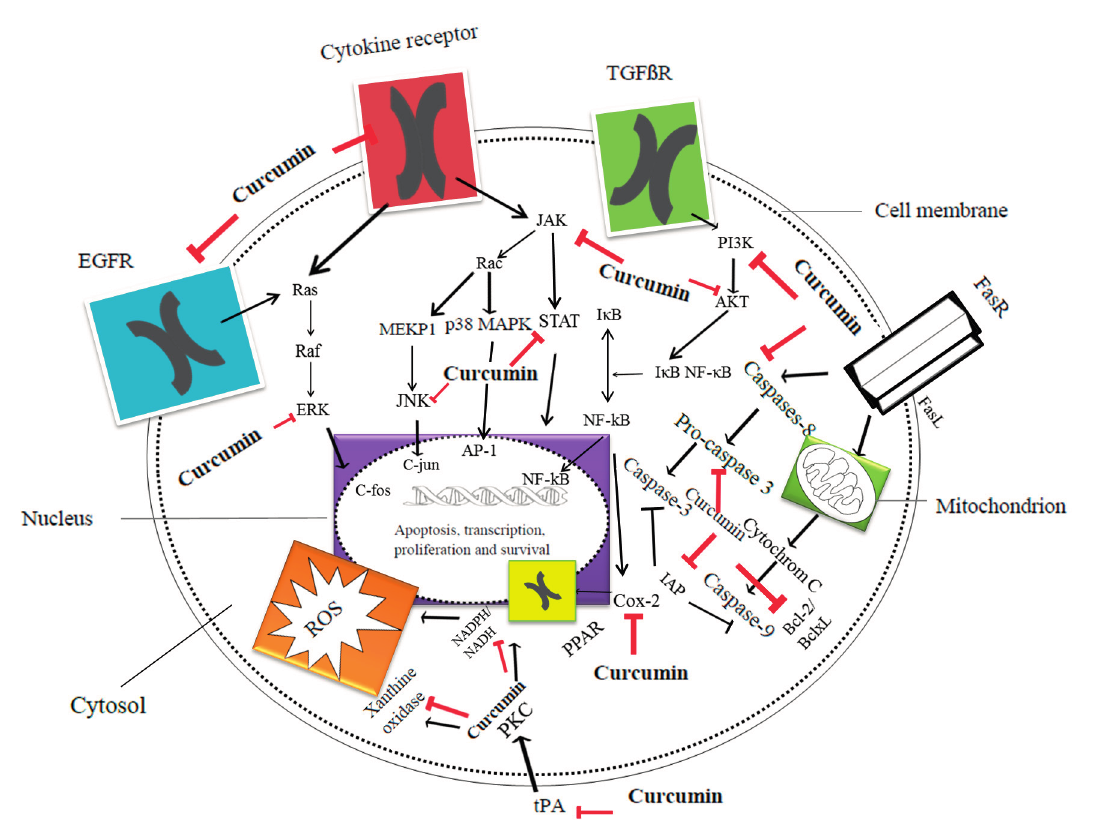
Figure 1. Major apoptotic and inflammatory pathways regulated by curcumin [49].